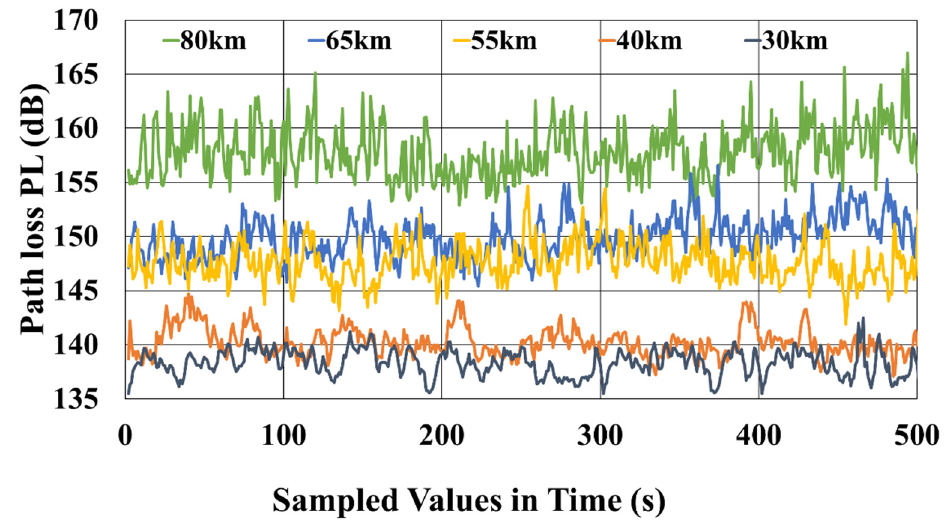
Figure 7. Measured path loss for 500 samples values at 30 km, 40 km, 55 km, 65 km and 80 km.